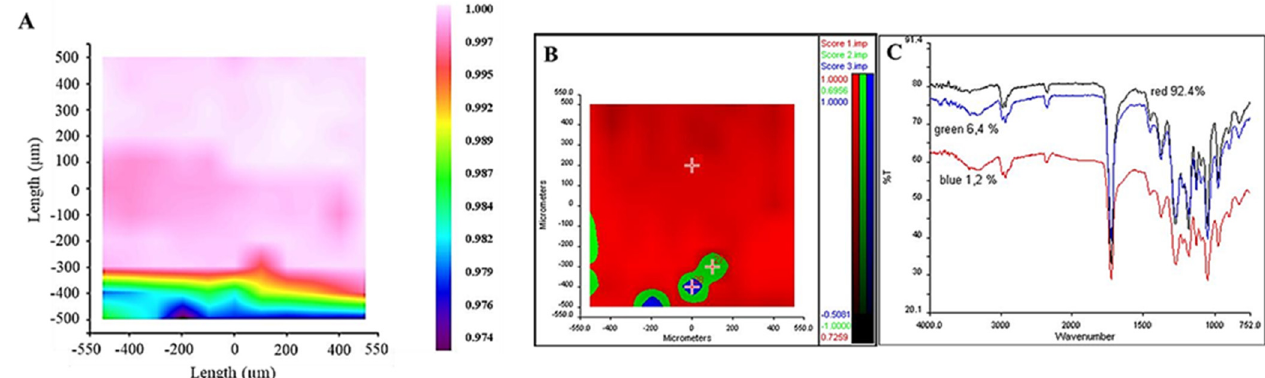
Figure 3. Results of chemical imaging analysis showing: ( A ) correlation map with the characteristic spectrum in the absorption region of the -OH groups. The correlation map shows values between 0.974 and 1.000 over the entire analyzed surface; ( B ) Statistical map elaborated by PCA to identify the zones on the map with the same spectral variability. The PCA analysis showed the presence of 3 spectral groups, identified in blue, green, and red; ( C ) Spectrum of each zone is represented in the graph of FT-IR spectra.